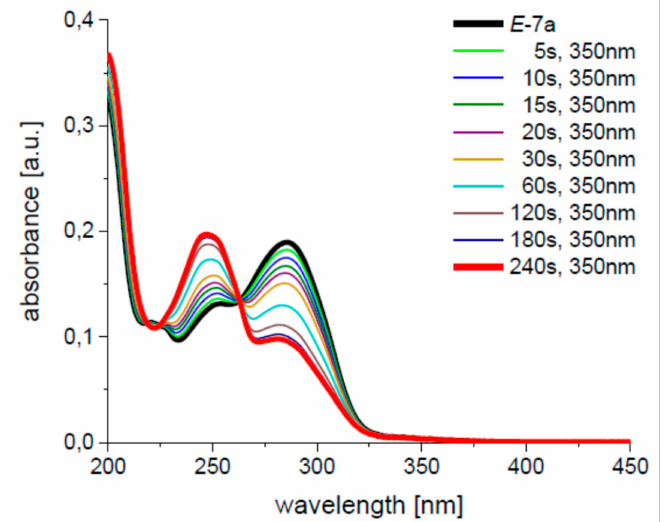
Figure 1. Direct photolysis of the α -methyl chalcone 7a at 350 nm (phosphor-coated mercury low- pressure lamps, 10 − 4 M solution in CH 3 CN); photostationary state (PSS) (37:63) is reached after 4 min (see experimental part for